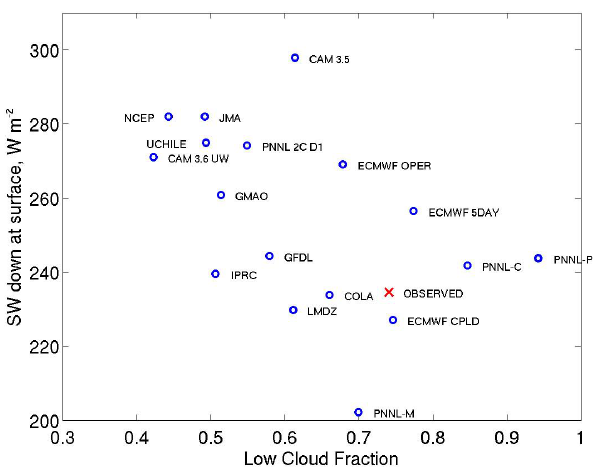
Fig. 7. Mean October 2006 downwelling shortwave radiation at the surface versus low cloud fraction for a 5 ◦ × 5 ◦ box centered at 85 ◦ W 20 ◦ S. The observed value (red x) comes from ISCCP FD data and MODIS liquid cloud